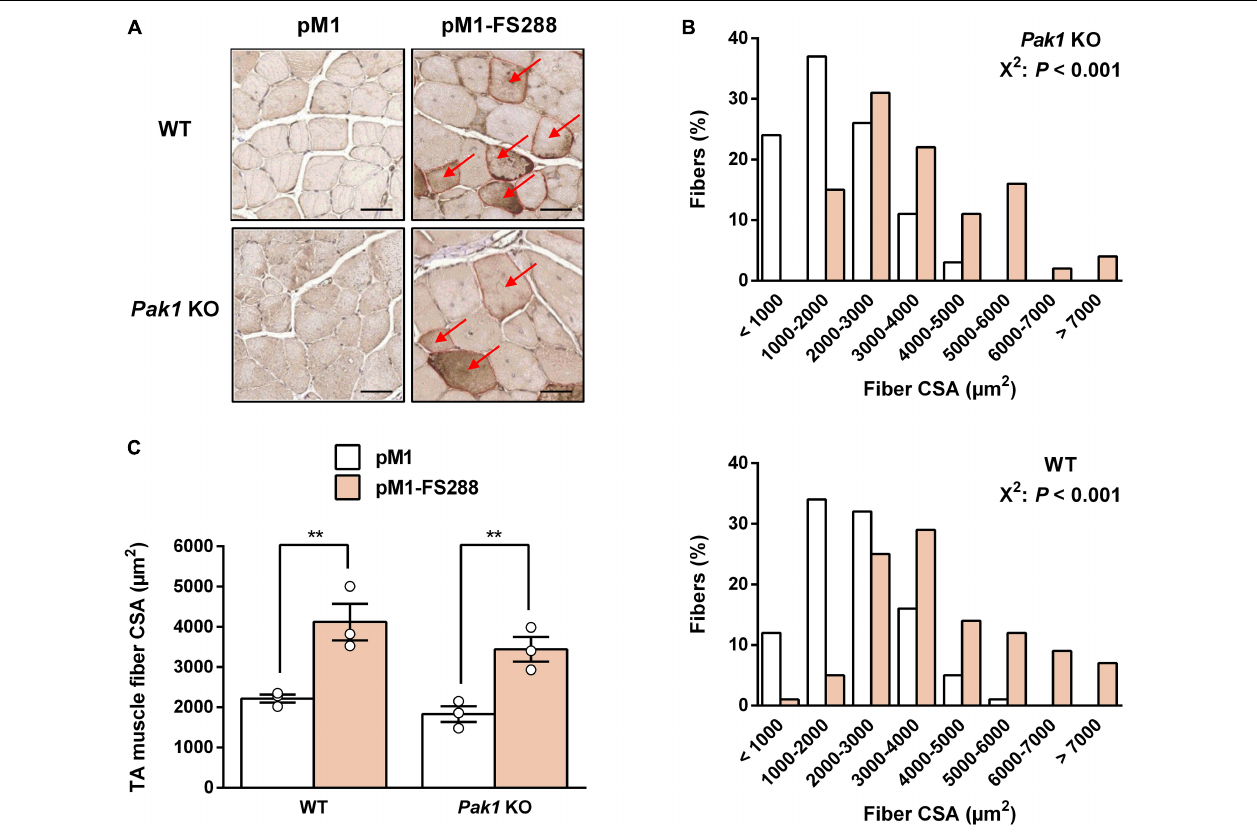
FIGURE 3 | Follistatin induces skeletal muscle hypertrophy despite the absence of Pak1 . (A) Representative FS-c-myc immunochemistry image from TA muscle of Pak1 KO and WT littermate mice. Red arrows indicate C-myc positive fibers. Scale bar = 50 µ m. (B) Muscle fiber size distribution from pM1-FS288-transfected vs. pM1-transfected TA muscles of Pak1 KO (up panel) and WT (bottom panel) mice ( n = 3/group). (C) Muscle fiber CSA assessed 17 days after electroporation of pM1-hFS288 (orange columns) or pM1 (white columns) in TA muscles from Pak1 KO vs. WT littermate mice ( n = 3/group). Results are expressed as mean ± SEM. Statistical analysis was performed using two-way ANOVA test and Bonferroni post-tests (FS effect: ** P < 0.01). Fiber CSA distribution statistical analysis was performed using χ 2 Pearson test ( P <